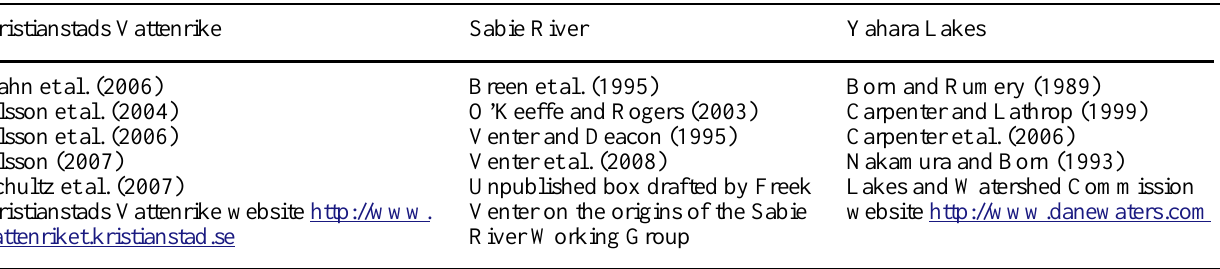
Table 1. Key literature sources used in each of the case